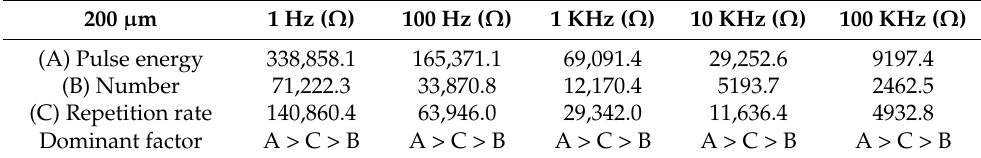
Table 5. The range analysis data for 200-diameter circular